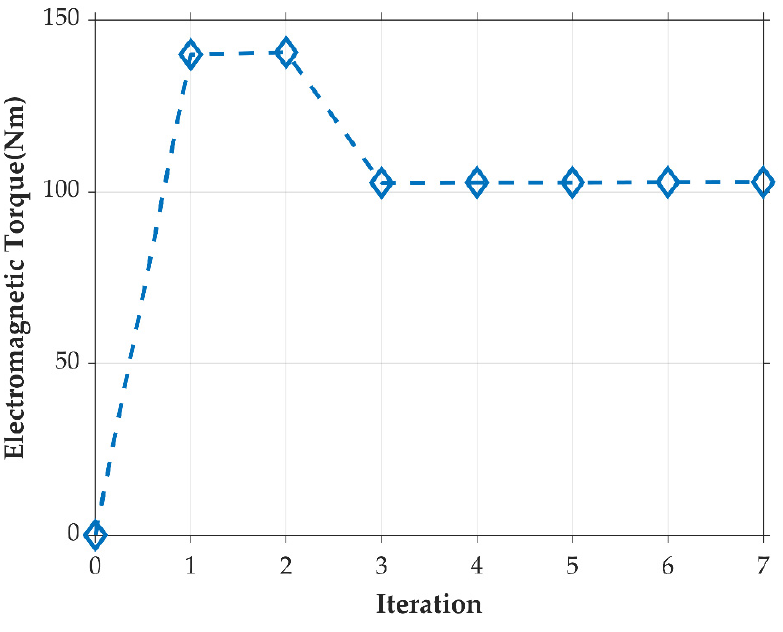
Figure 11. Electromagnetic torque of the machine.